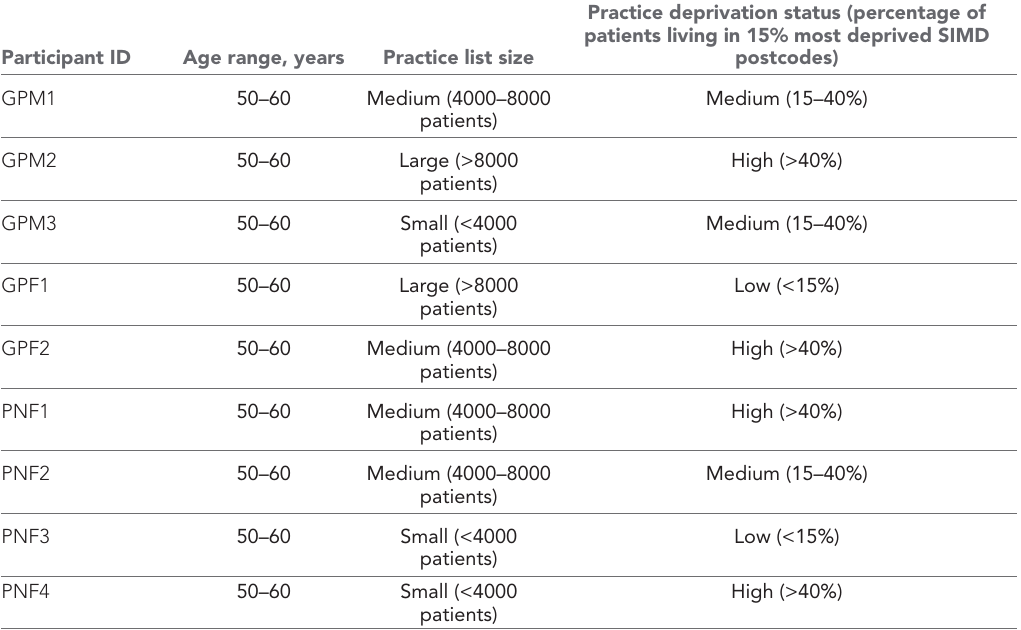
Table 3 Practitioner